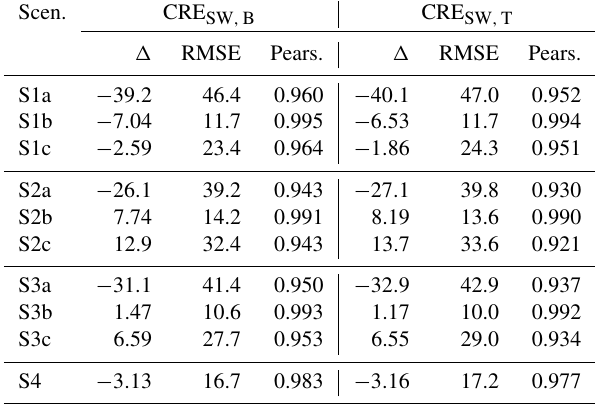
Table 8. Mean CRE (Wm − 2 ) for the SW radiation. Results are given as differences between the new scenario and the reference simulation ( (cid:49) ). The RMSE in Wm − 2 and the Pearson (Pears.) cor- relation between the new scenarios and the reference simulation are also